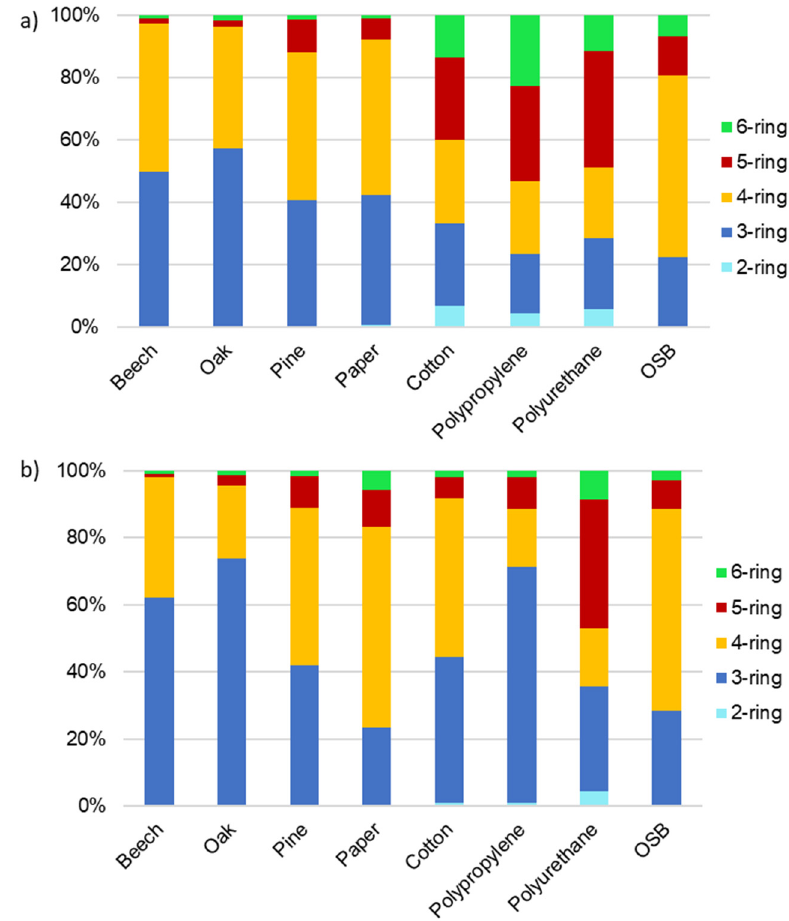
Figure 5. Profiles of PM 4 - ( a ) and TSP-bound ( b ) PAHs during burning of various types of materials ( r = 0.919, p < 0.001).